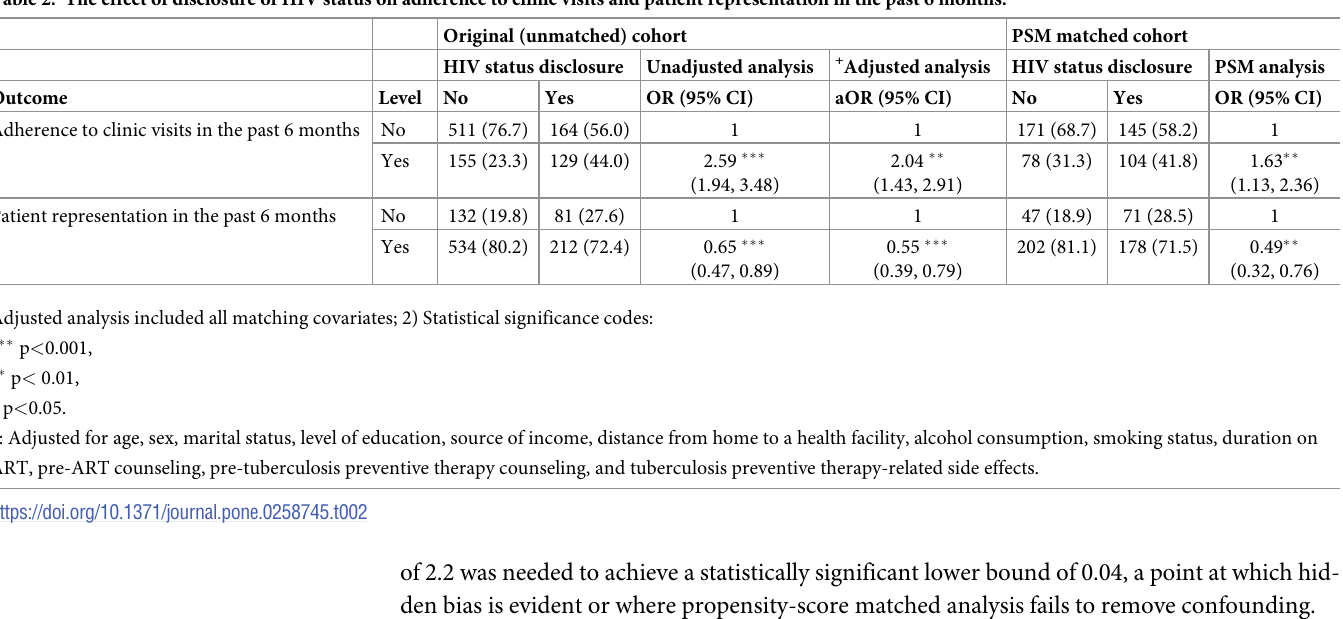
Table 2. The effect of disclosure of HIV status on adherence to clinic visits and patient representation in the past 6 months.